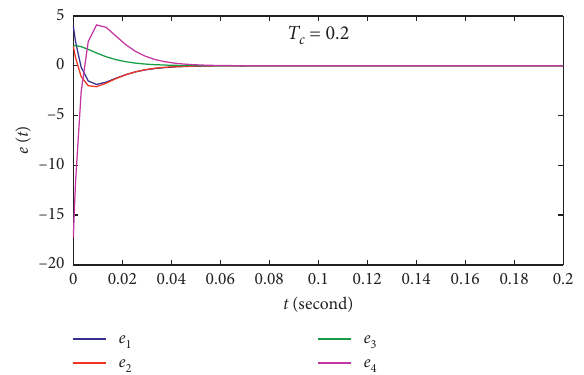
Figure 10: Time response of MFPS error e with T